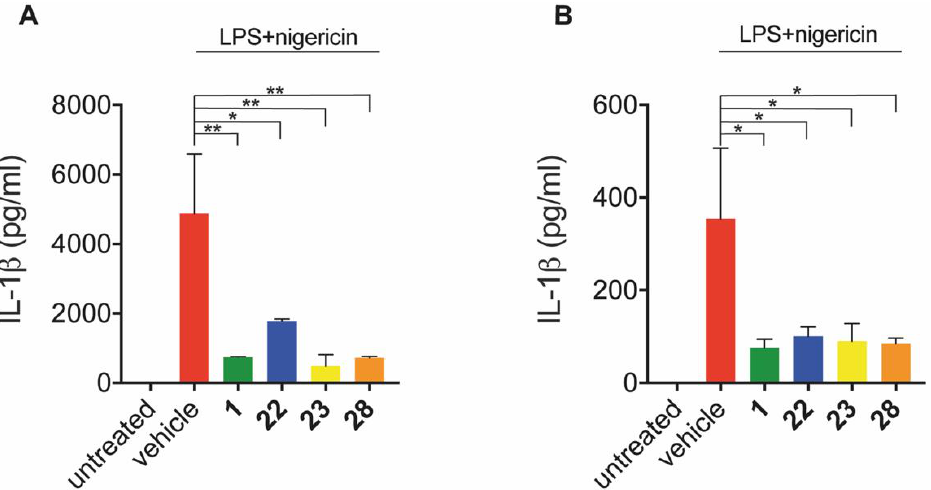
Figure 2. In vitro inhibition of IL-1 β release. ( A ) BMDMs were stimulated with LPS (1 µ g/mL) for 2 h, then treated with compounds for 30 min, and then activated with nigericin (10 µ M) for 1 h. Cell